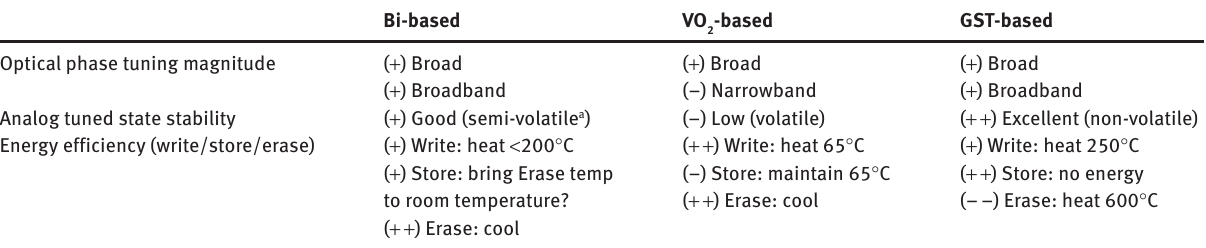
Table 1: The tentative benchmarking of the active optical phase tuning performance of Bi-, VO driven applications requiring analog optical memory capabilities in the visible range, such as rewritable optical data storage platforms with enhanced information density or bistable photonic switches with a tunable “on”